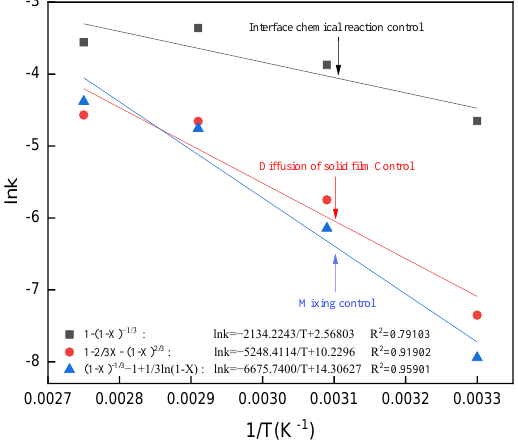
Figure 20. Curves of lnK − 1/T to aluminum ions.